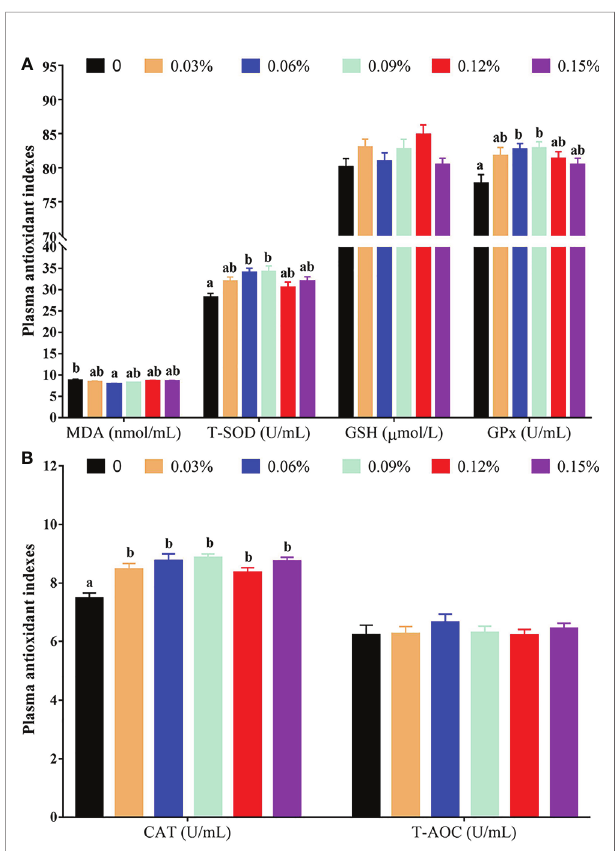
FIGURE 1 | The results of plasma antioxidant indexes with different levels of TB supplementation. (A) MDA, malondialdehyde; T-SOD, total superoxide dismutase; GSH, glutathione; GPx, glutathione peroxidase; (B) CAT, catalase; T-AOC, total antioxidant capacity. Data are expressed as means with S.E. Value with different superscripts are signi fi cantly different (P <